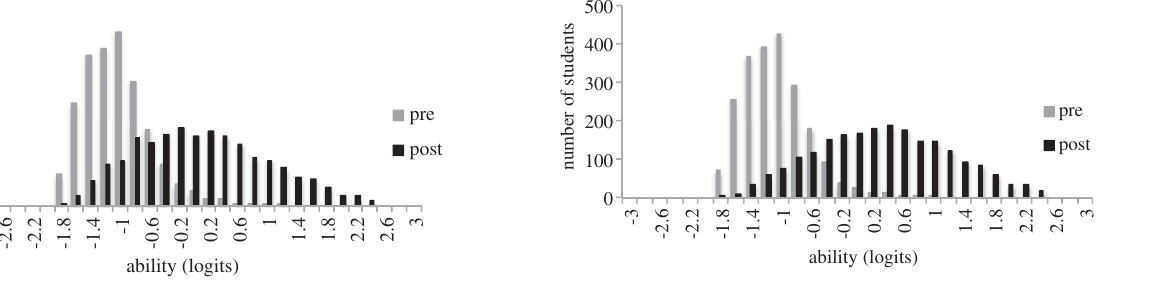
FIG. 4. The distribution of pre- and postinstruction abilities for all 3205 students in the data set.